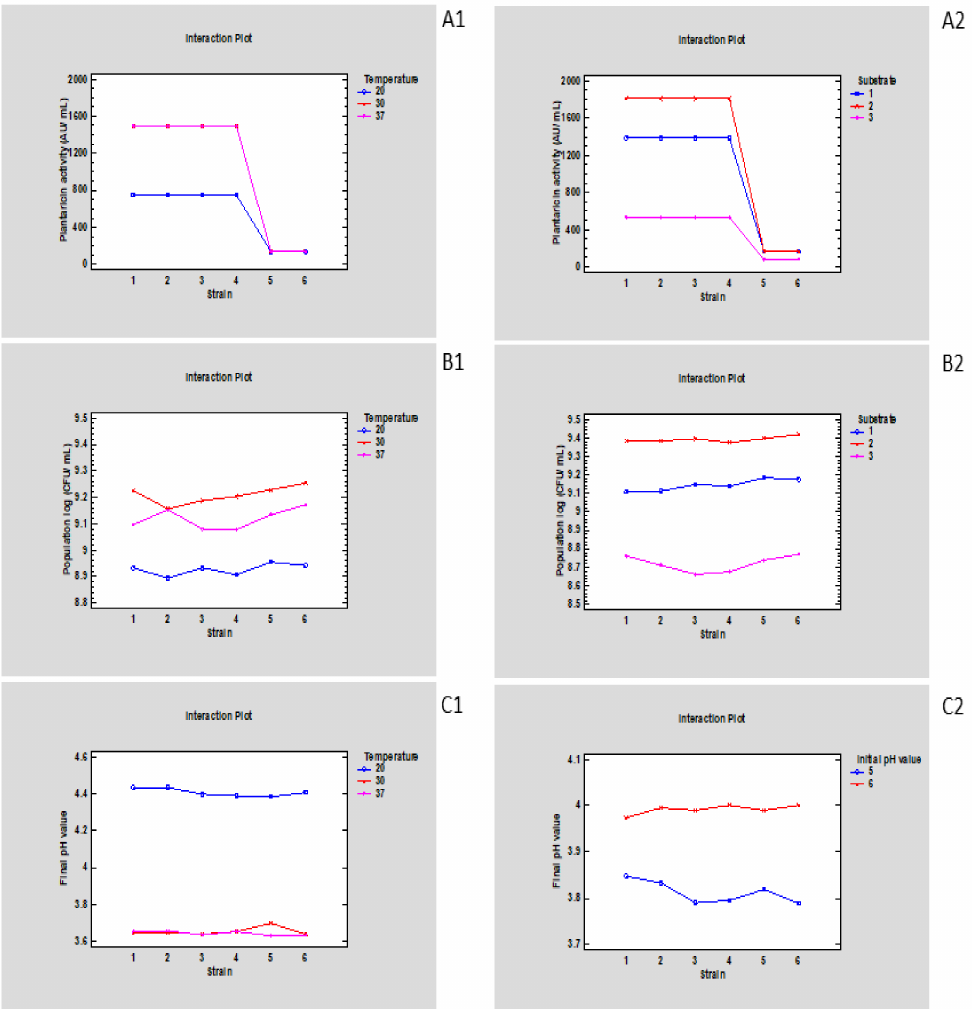
Figure 1. Interaction plots depicting the mean plantaricin activity, population and final pH value, obtained from the combination of two sourdough related parameters. ( A1 , A2 ) The effect on mean plantaricin activity (AU/mL), resulting from the in pair interaction of strains with temperatures and substrates, respectively, after growth for 21 h. ( B1 , B2 ) The effect on mean population, log (CFU/mL), resulting from the in pair interaction of strains with temperatures and substrates, respectively, after growth for 21 h. ( C1 , C2 ) The effect on mean final pH value, resulting from the in pair interaction of strains with temperatures and initial pH value, respectively, after growth for 21 h. Six Lp. plantarum strains were included, namely, LQC 2441, 2422, 2516, 2485, 2320 and 2520 corresponding to 1, 2, 3, 4, 5 and 6, three incubation temperatures, namely, 20, 30 and 37 ◦ C, three substrates, namely, MRS broth, mMRS broth and WFE corresponding to 1, 2 and 3 and two initial pH values (5.0 and